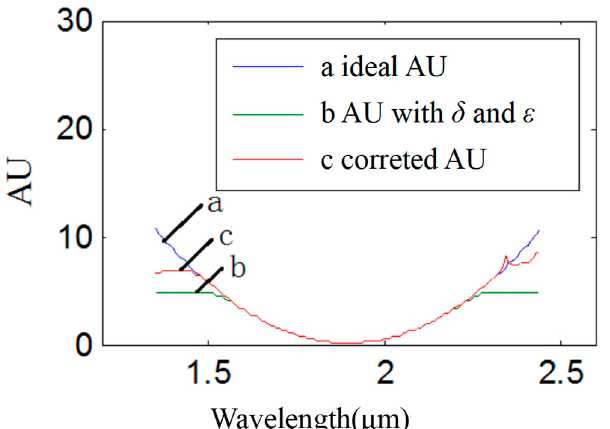
Figure 11. Results of absorbance correction in Hadamard mode: the horizontal ordinate shows the